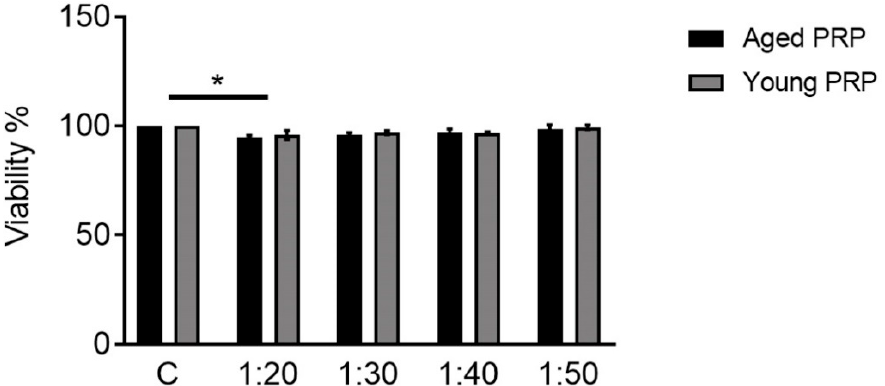
Figure 5. Evaluation of PRP toxicity with calcein assay in primary cultures of neurons from rat E16-18 cortices, with different plasma concentrations (dilutions): 1:20, 1:30, 1:40, or 1:50. * p < 0.05. Error bars = standard deviation.